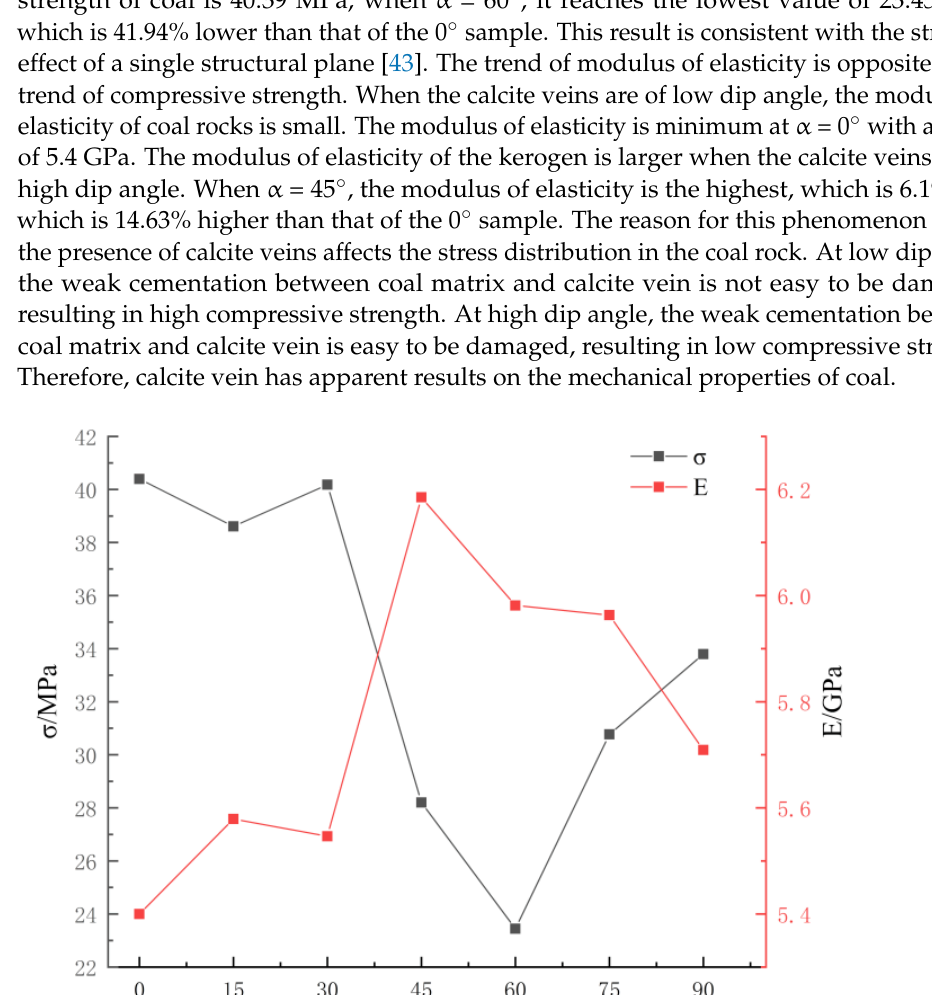
Figure 5. Stress − strain relation curves of coal and rock under diverse azimuth angles.